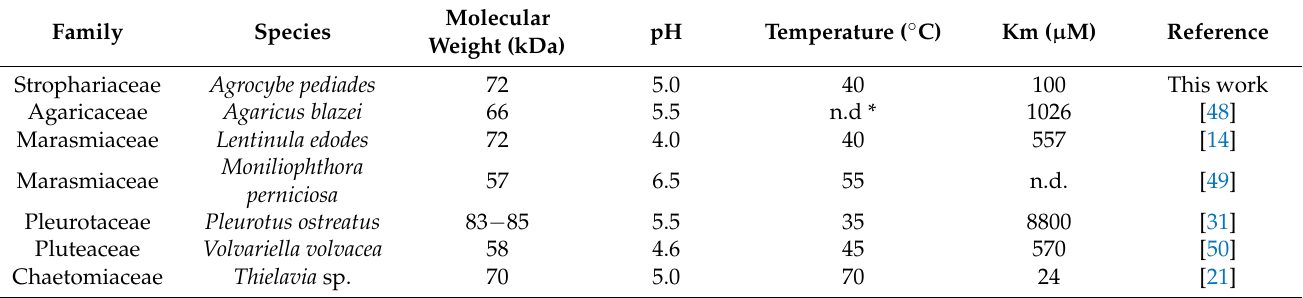
Table 2. Properties of laccase enzymes purified from fungi of the Agaricales